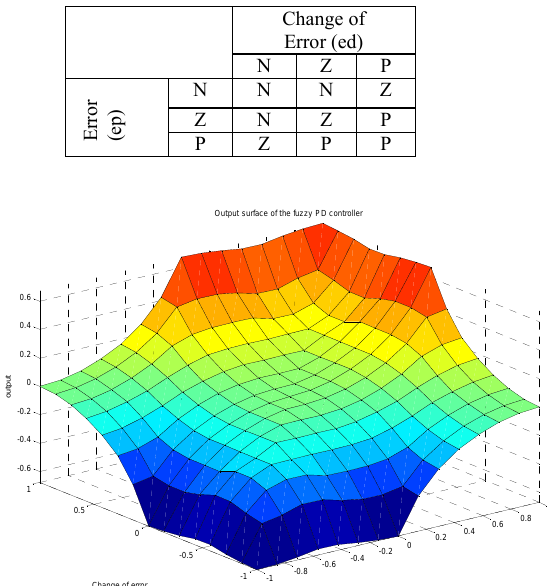
Table 1 Fuzzy Precompensated PD Controller rules